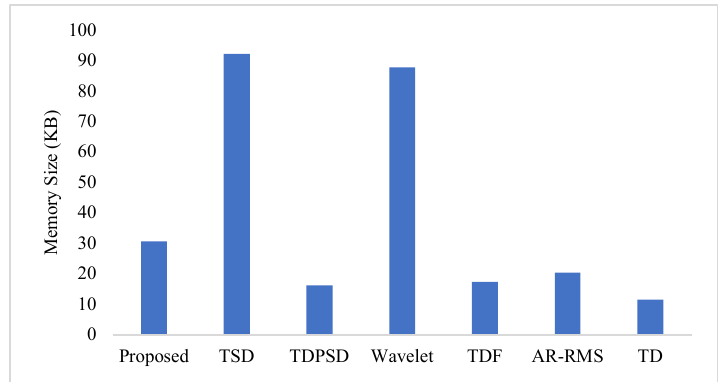
Figure 12. The memory size for different feature extraction methods.